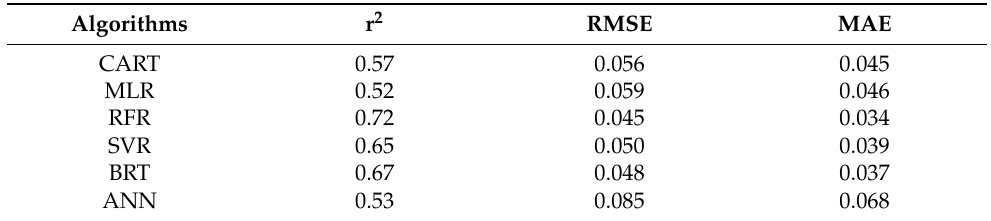
Table 1. Comparison of the machine learning algorithms for soil moisture prediction using coefficient of determination (r 2 ), root mean squared error (RMSE), and mean absolute error (MAE). Algorithms included classification and regression trees (CART), multiple linear regression (MLR), random forest regression (RFR), support vector regression (SVR), boosted regression trees (BRT), and artificial neural networks